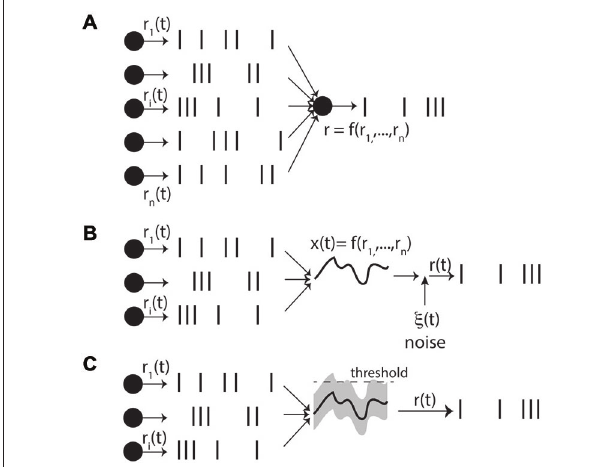
FIGURE 5 | The rate-based view . (A) Each neuron is described by a private quantity r(t), its rate, which determines the spike trains through a stochastic process. Crucially, even though only the spike trains are directly observed by the neuron, it is postulated that the rate r(t) only depends on the presynaptic rates r i (t), and not on the spike trains themselves ( f can be a function, dynamical process or filter). (B) One option is that synaptic integration leads to a quantity x(t); (e.g., membrane potential) that only depends on the rates r i (t) by law of large numbers. As x(t) is deterministic, private noise must be added so as to produce stochastic spike trains. (C) The other option is that there are random fluctuations around the mean x(t) due to the spiking inputs, causing output spikes. For these fluctuations to depend only on the rates, the presynaptic processes must be independent, but we note that we have now introduced correlations between inputs and